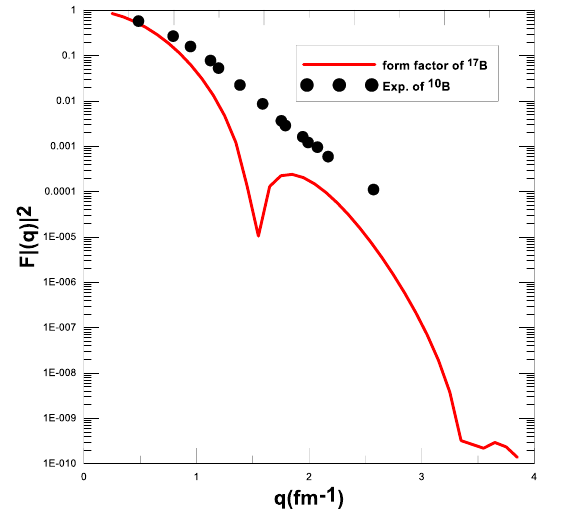
Figure 2: Comparison between the calculated elastic form factors of 17 B and the experimental data of 10 B.